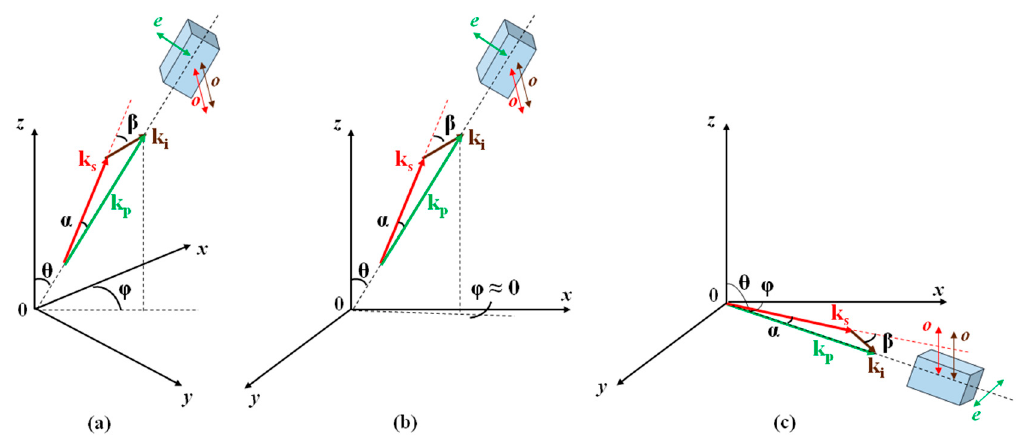
Figure 13. The orientation of nonlinear crystals for UBB phase-matching bandwidth, type I ( oo → e ) parametric interaction. ( a ) DKDP crystal. ( b ) BBO crystal. ( c ) LBO crystal. DKDP and BBO are uniaxial negative crystals, n x = n y = n o , n z = n e , n o > n e . The NOPA